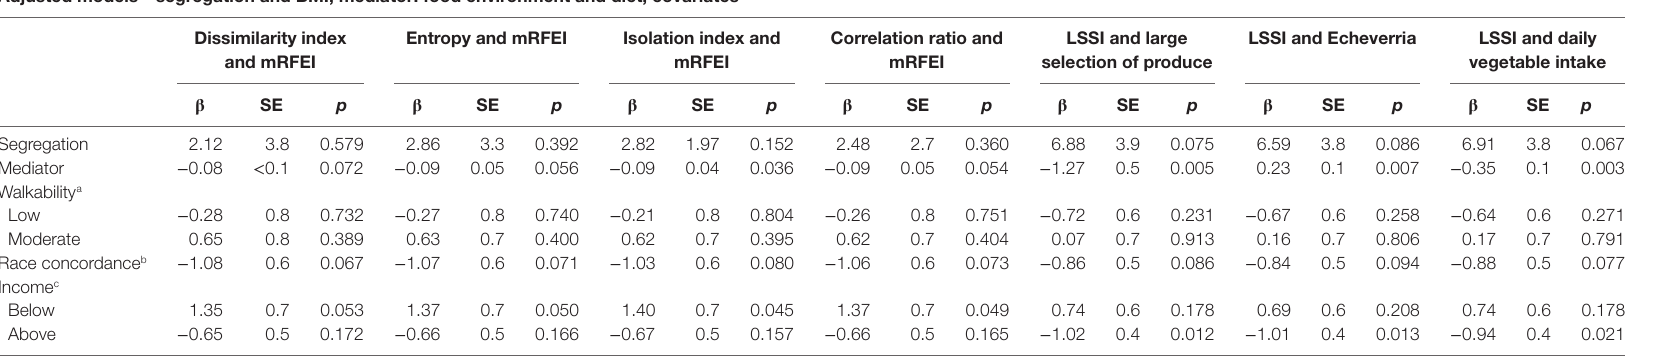
adjusted models—segregation and BMi, mediator: food environment and diet, covariates